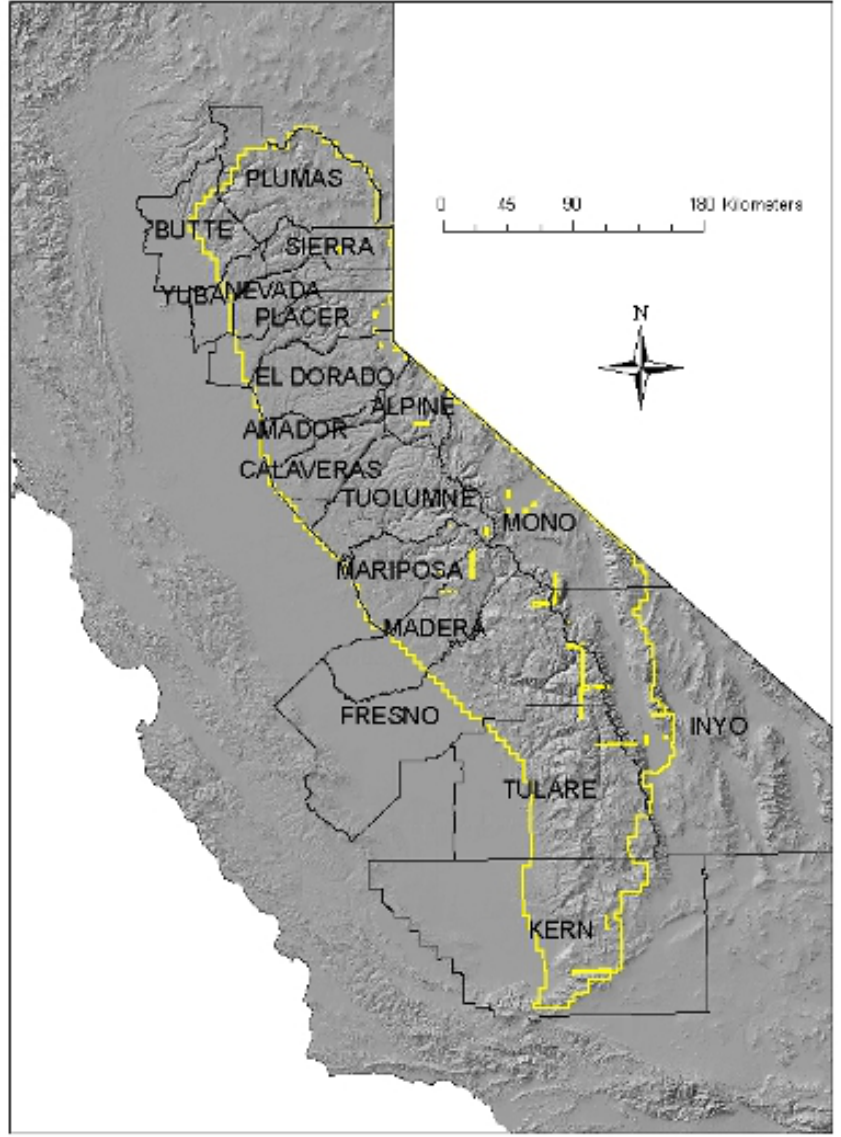
Fig. 3. The Sierra Nevada bioregion of California (yellow lines) displayed on a shaded relief image. Internal yellow lines indicate poorly surveyed boundaries in the public land survey system; black lines indicate county names and